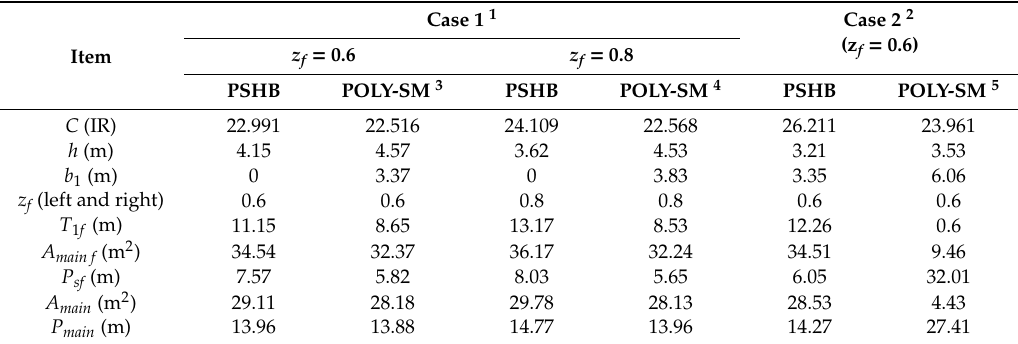
Table 6. Optimal characteristics of simple polynomial section with smooth corners (POLY-SM) and parabolic section (PSHB) for restricted inverse side